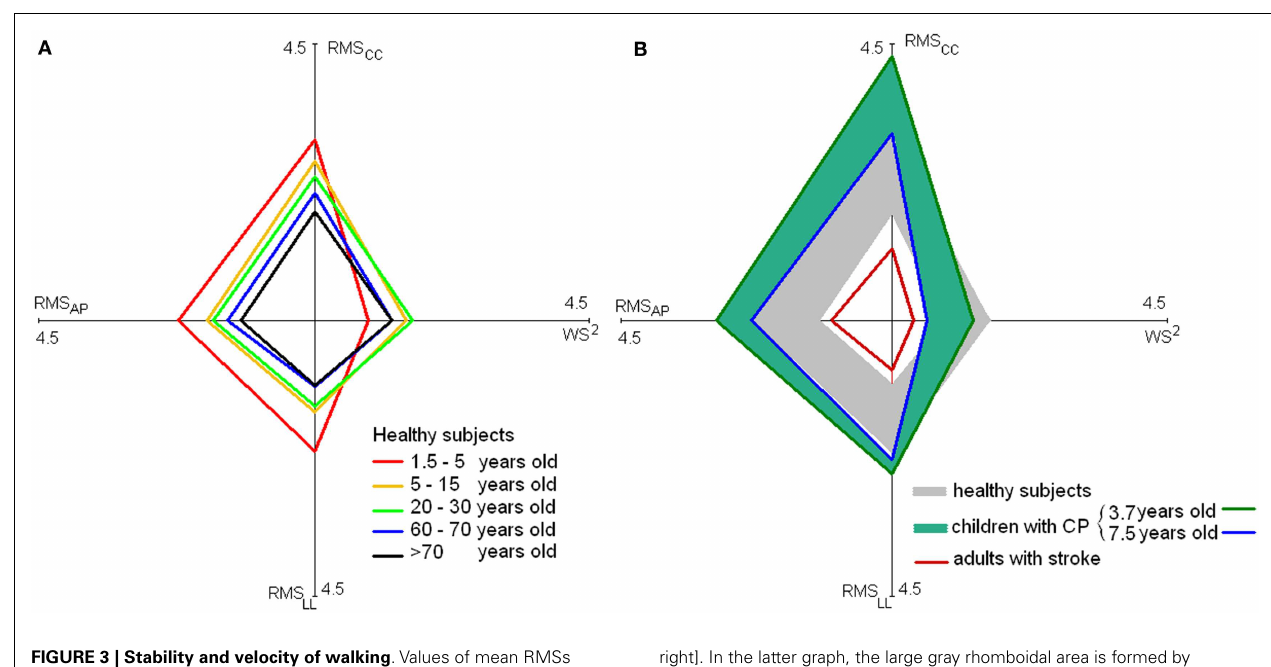
FIGURE 3 | Stability and velocity of walking .Values of mean RMSs [along the antero-posterior (AP), latero-lateral, (LL) and cranio-caudal (CC) axes] andWS 2 for healthy subjects at various ages [ (A) , on the left] and for children with cerebral palsy and adults with stroke [ (B) , on the